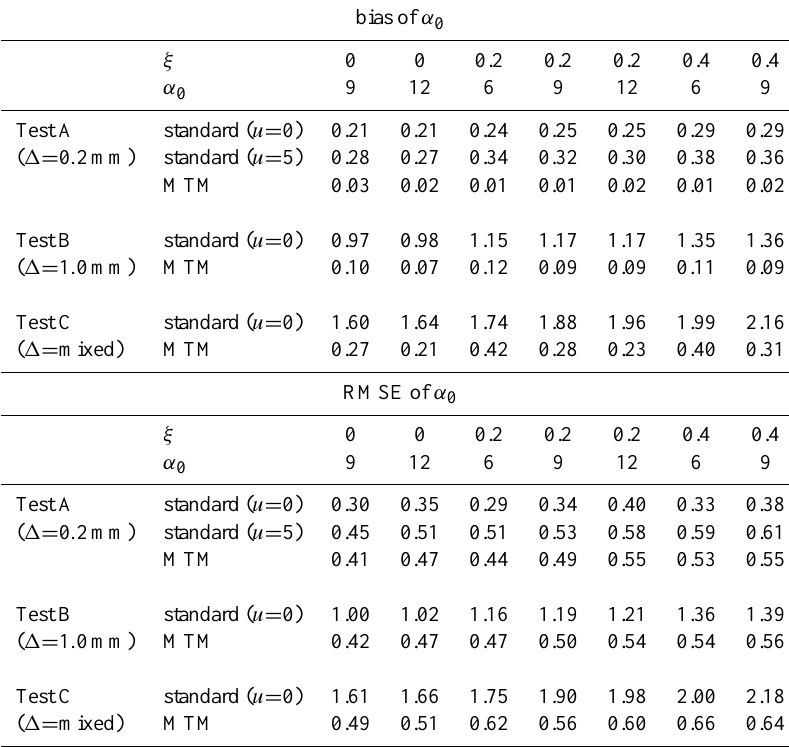
Table 2. Same as Table 1 but for α 0